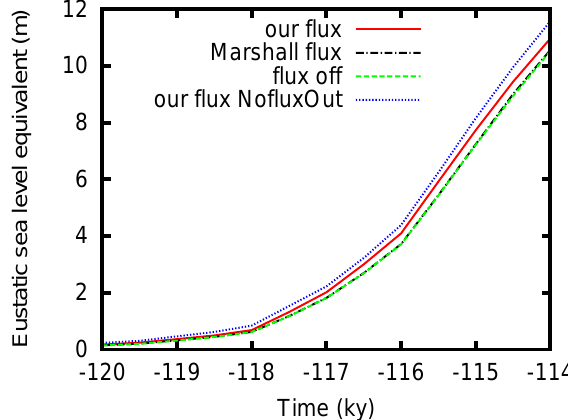
Figure 14. Ice volume evolution for a simulation over North Amer- ica (parameter vector nn9894) with the SG model turned on during inception. “our flux” represents the flux code used in our SG model and “Marshall flux” the flux code used in Marshall et al. (2011) experiment. “flux off” represents the simulation with no ice flux be- tween SG bins and “NofluxOut” has no SG flux between coarse grid cells (but SG fluxes within each coarse grid cell are still